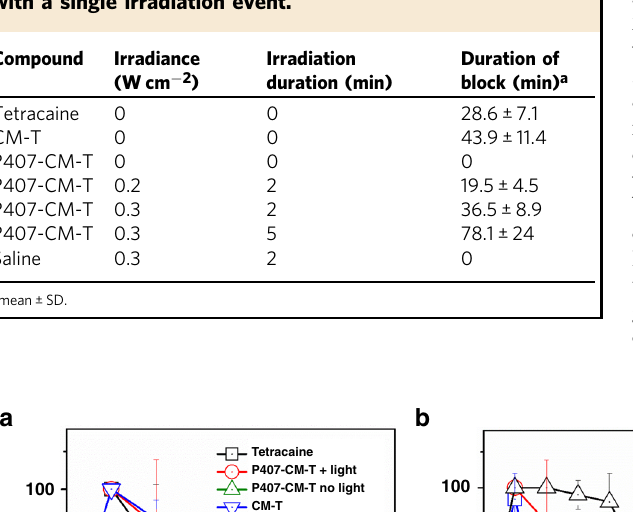
Table 1 Duration of block for different compounds without or with a single irradiation event.